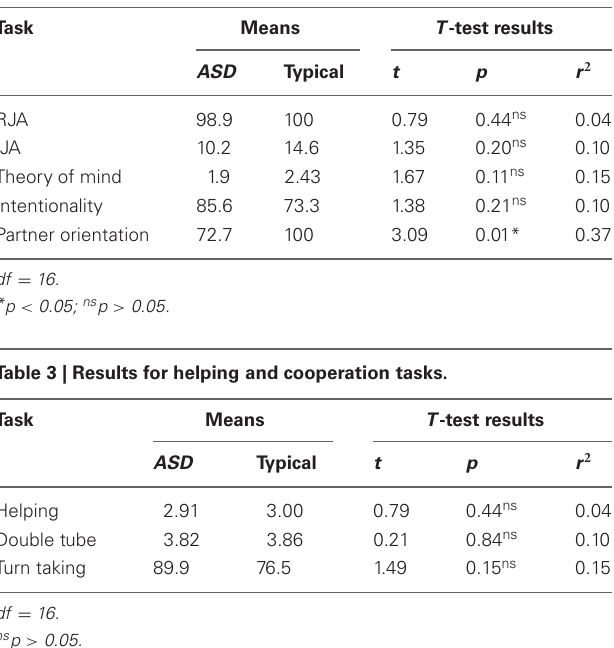
Table 2 | Results for cognitive tasks.